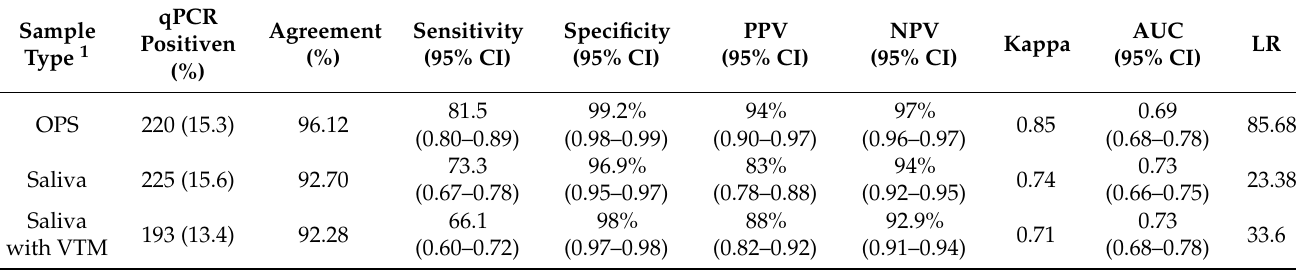
Table 4. Validation parameters of the saliva and OPS tests compared with NPS (gold standard